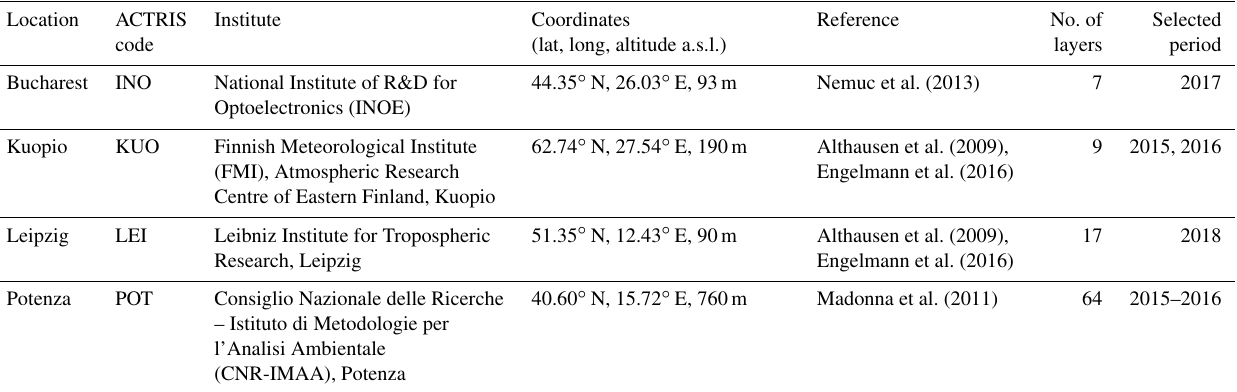
Table 2. EARLINET lidar station information.